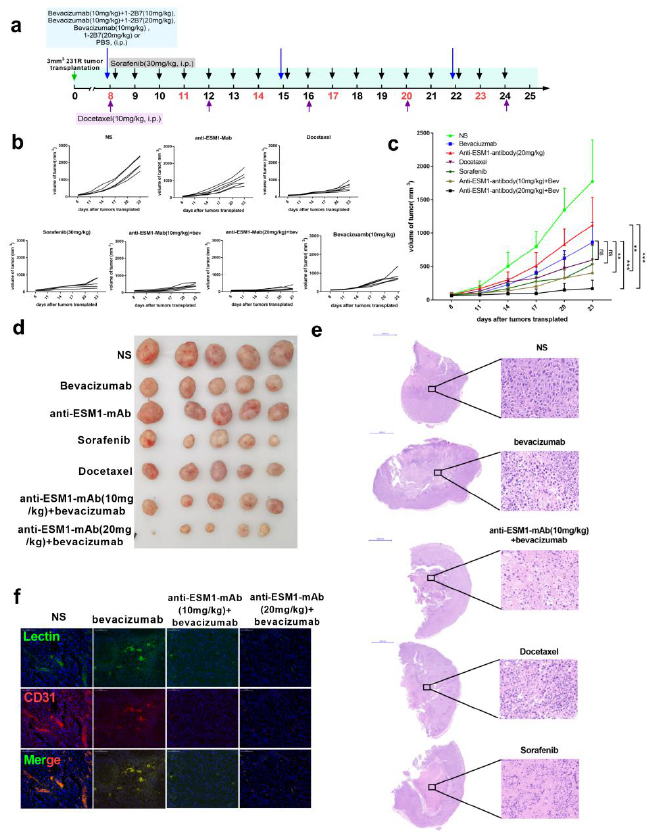
Figure 8. Anti-ESM1 monoclonal antibody alleviated bevacizumab resistance. ( a ) Schematic of experimental design for MDA-MB-231-R-bearing mice model treated with normal saline, docetaxel (10 mg/kg), sorafenib (30 mg/kg) and bevacizumab (10 mg/kg), anti-ESM1-monoclonal antibody (20 mg/kg), or combination bevacizumab with anti-ESM1-smonoclonal antibody with different dosages. ( b ) Tumor growth volume of every mouse in each group over time following subcutaneous transplant of tumor tissues into balb/c nude mice. ( c , d ) Tumor growth volume and photos over time following subcutaneous transplant of tumor tissues into balb/c nude mice. ** p < 0.01; *** p < 0.001 by two-way ANOVA test. ( e ) Representative H&E staining image of tumor sections from mice treated with normal saline, Sorafenib, Docetaxel, bevacizumab and both bevacizumab and anti-ESM1 monoclonal antibody. Scale bar, 2000 µ m (left) and 50 µ m (right). ( f ) Representative images of tumor sections from mice treated with normal saline, bevacizumab, and both bevacizumab and anti-ESM1 monoclonal antibody. CD31 was co-stained with DL488 labeled Lectin and nucleus. Scale bar, 100 µ